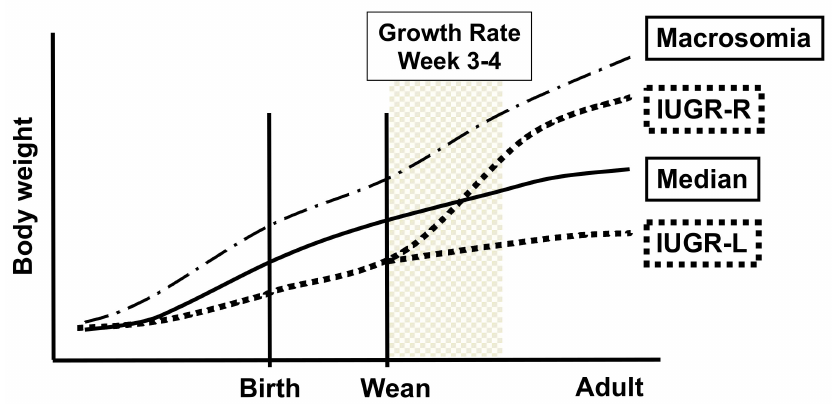
Figure 11. Centile crossing by IUGR-R male mice. IUGR-R mice show 120% increase in body weight during the first week (week 3–4) after weaning that by week four results in IUGR-R males having a body weight similar to that of males that were macrosomic at birth (see Figure